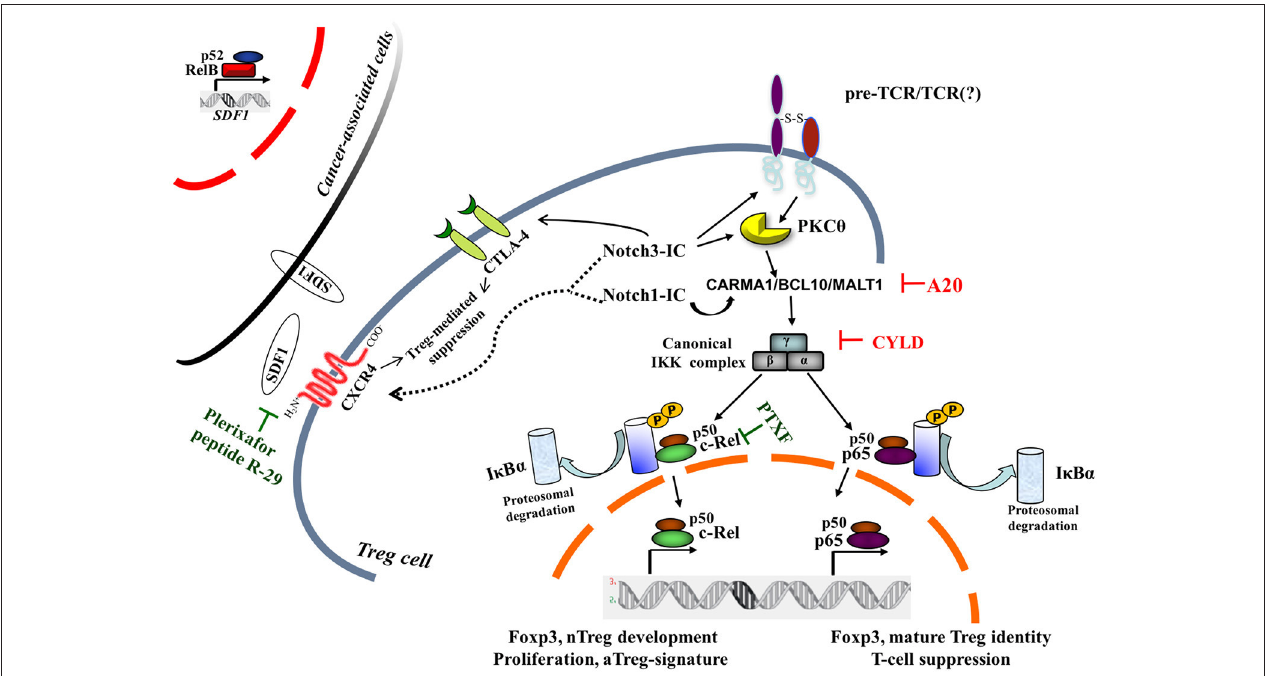
FIGURE 1 | Canonical NF- κ B pathway is central to intrinsic Notch1- and Notch3-modulated Treg cell function within tumor microenvironment. Two NF- κ B negative regulators, A20 and CYLD, on removal of nonproteolytic K63-linked polyubiquitin chains from signaling molecules, interfere with the preTCR/TCR pathway, leading to NF- κ B activation. For a pharmacological approach, pentoxifylline (PTXF) that selectively degrades c-Rel is indicated, as well as inhibitors of Treg-mediated suppression activity by CXCR4 antagonists, such as plerixafor (AMD3100) or peptide R-29. The dotted line refers to hypothetical Notch1- and/or Notch3-induced CXCR4 modulation in Treg cells, whereas the black curved-line indicates the Notch3-enhanced CTLA4 expression in N3-ICtg Tregs ( 36). Cancer-associated cells once activated in a tumor microenvironment can express many proinflammatory genes, including stromal cell-derived factor 1 (SDF1), the cognate ligand of CXCR4, partly in an NF- κ B-dependent manner (23). pT α -chain (preTCR) and T-cell receptor (TCR); I κ B α , inhibitor of NF- κ B α